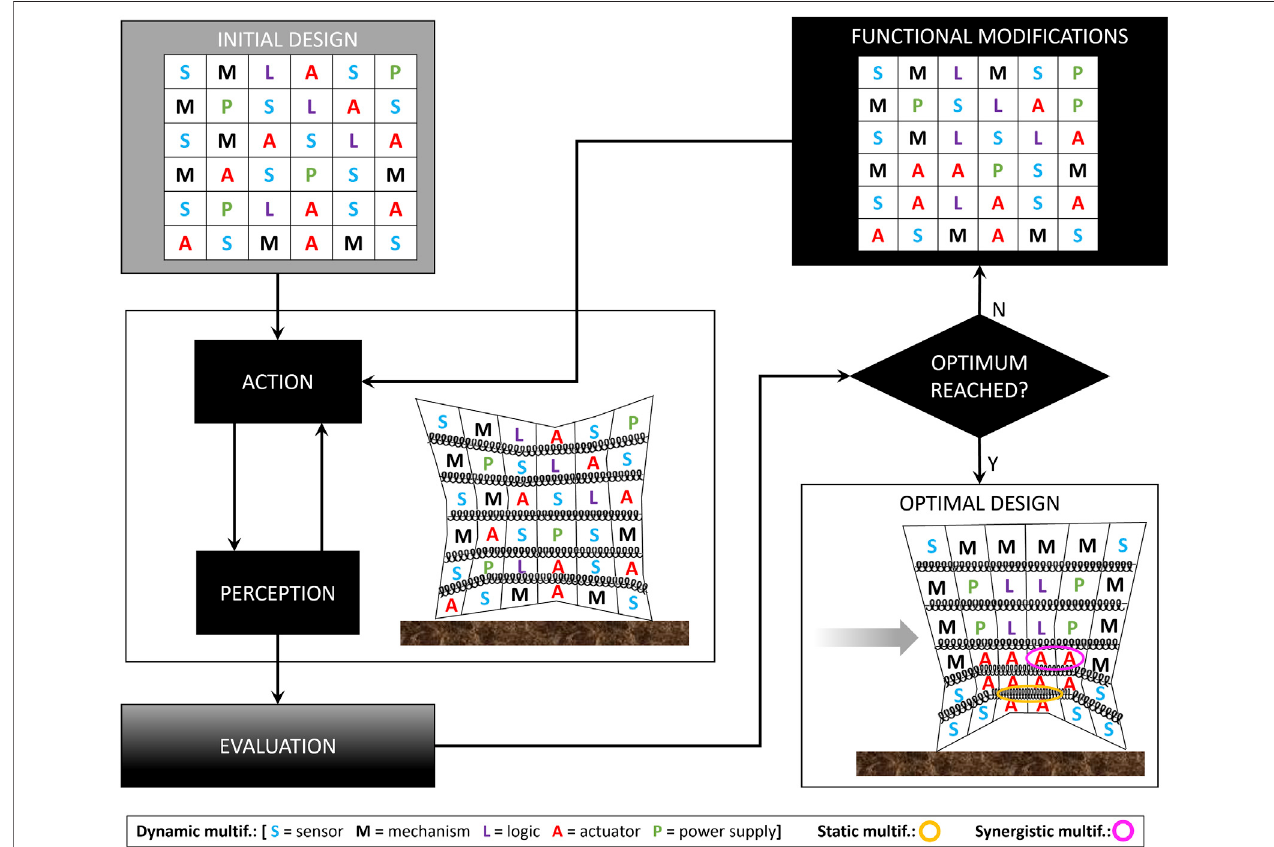
FIGURE 2 | Simpli fi ed example of implementation of fl exible design approach for a locomotion task. Tasks in grey blocks are expected to be executed by the designer/user.Thesystemdesigncanbeinitializedevenwithpooraprioriknowledge,withsomearbitrariness,butpossiblywithhighredundancy;thesystemisthenleft freeto interact withthe environment and through action/perception loops itcollects data that areused for the evaluation process (performed bythe designer or possibly by the system itself); if an optimal behaviour is not reached, body components undergo functional modi fi cations (thanks to their multifunctionality) and another iteration starts; this is repeated until an optimal behaviour is reached. Letter change indicates the change of functionality thanks to dynamic multifunctionality; fl uidic tubing exploited as additional spring element (in yellow) represents a static multifunctionality; synergistic multifunctionality is highlighted in violet where actuators can couple their